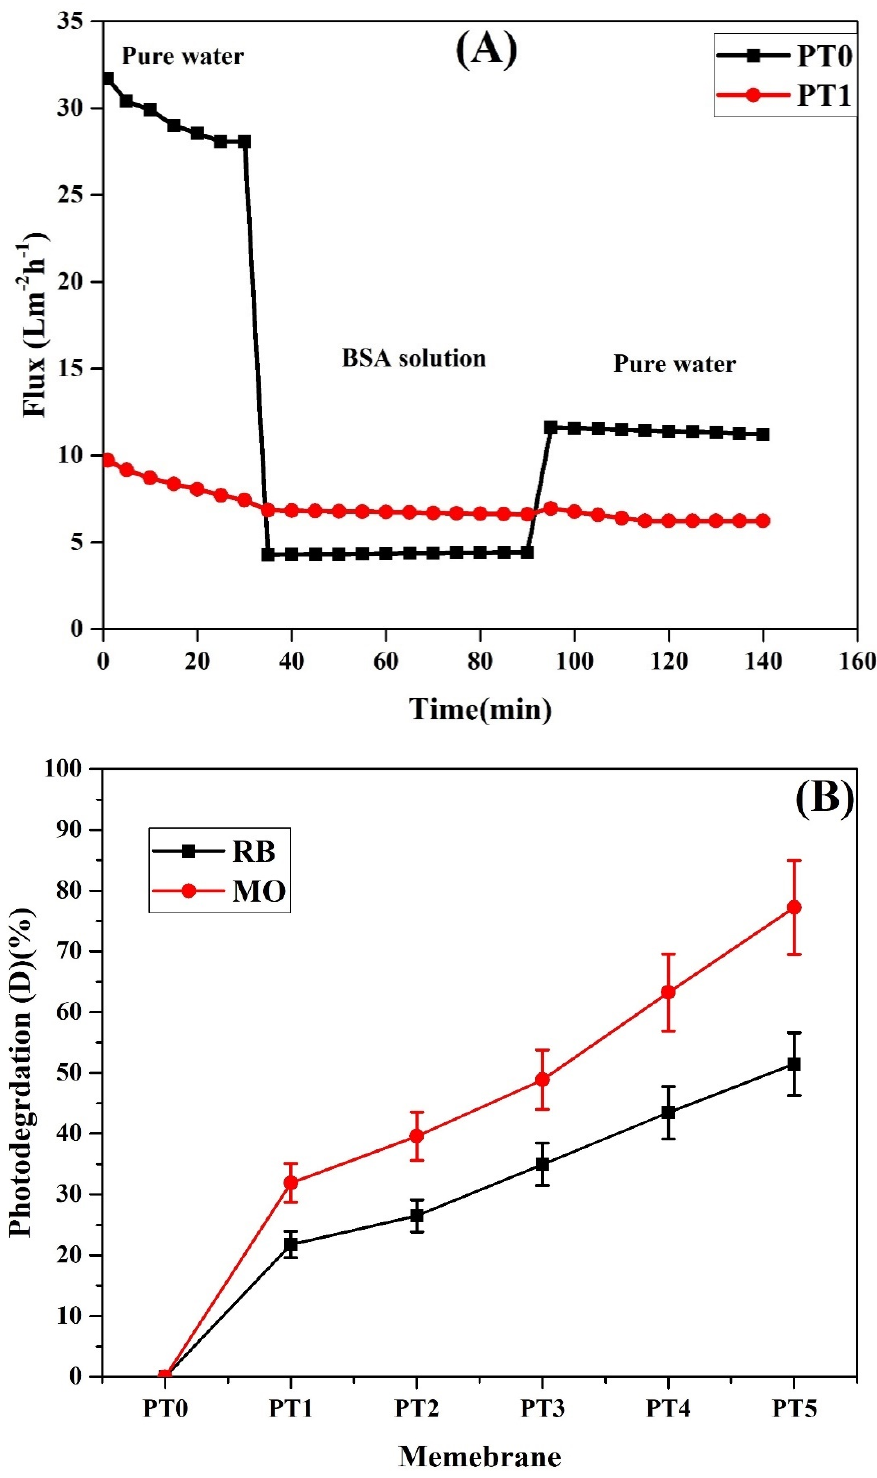
Figure 7. ( A ) Bovine serum albumin (BSA) removal using plain and modified membranes (PT0 and PT1) (BSA concentration = 1 g/L, operating pressure = 3 bar); ( B ) Photocatalytic degradation of dyes (reactive blue and methyl orange) at a dye concentration of 50 mg/L under UV irradiation for 150 min.